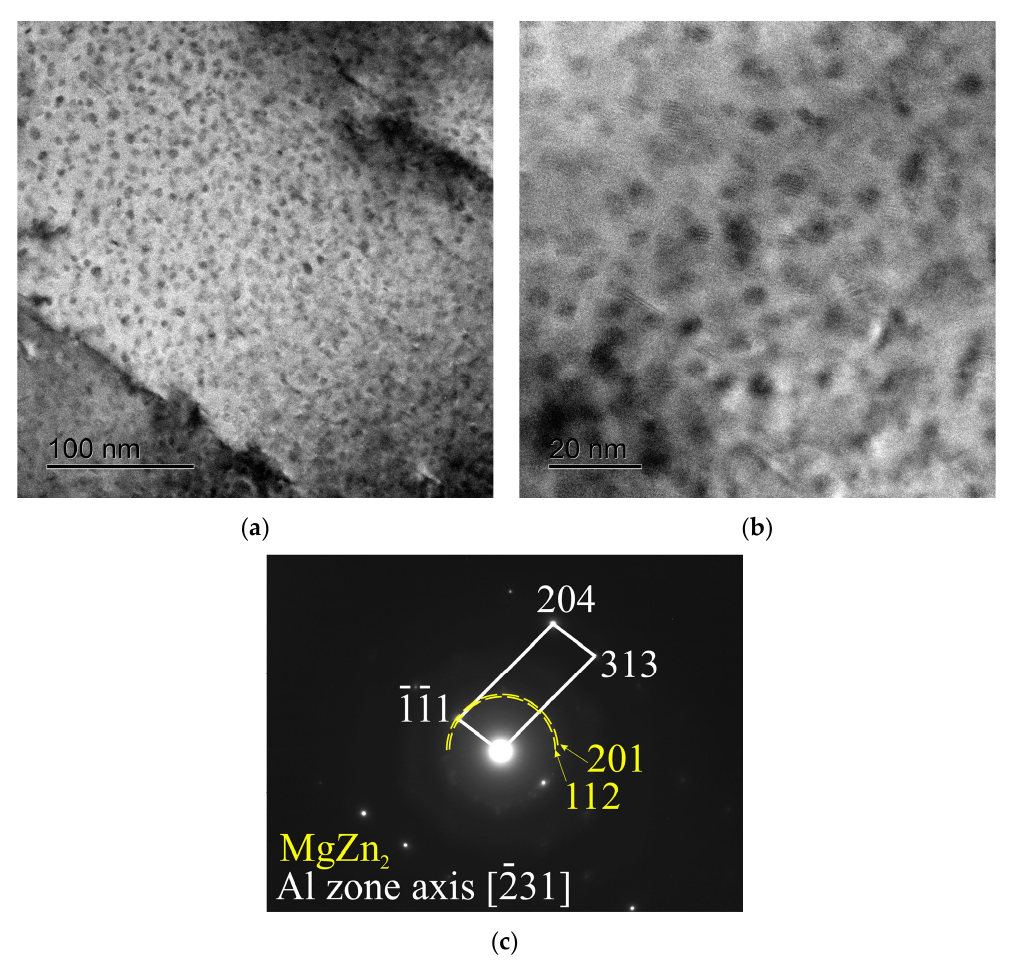
Figure 11. TEM structure of the experimental alloy after solution treatment and aging (150 °C, 6 h): ( a ) dark field, ( b ) high resolution image, and ( c ) selected area diffraction patterns (SADP) taken along the [ − 231]Al zone axis.